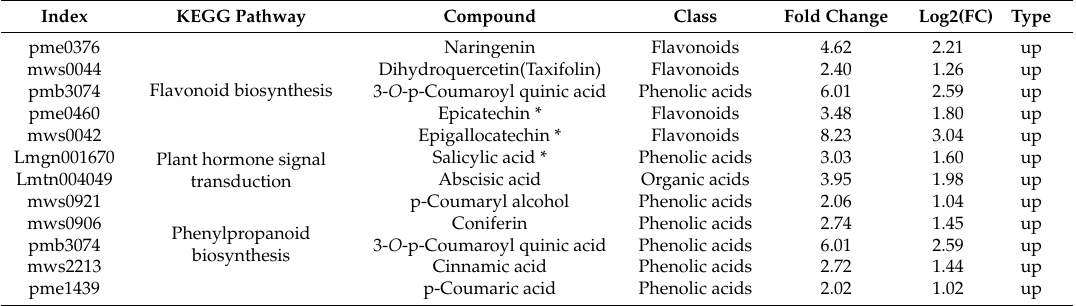
DAMs involved in Flavonoid biosynthesis, Plant hormone signal transduction and Phenylpropanoid biosynthesis. The asterisks represents an